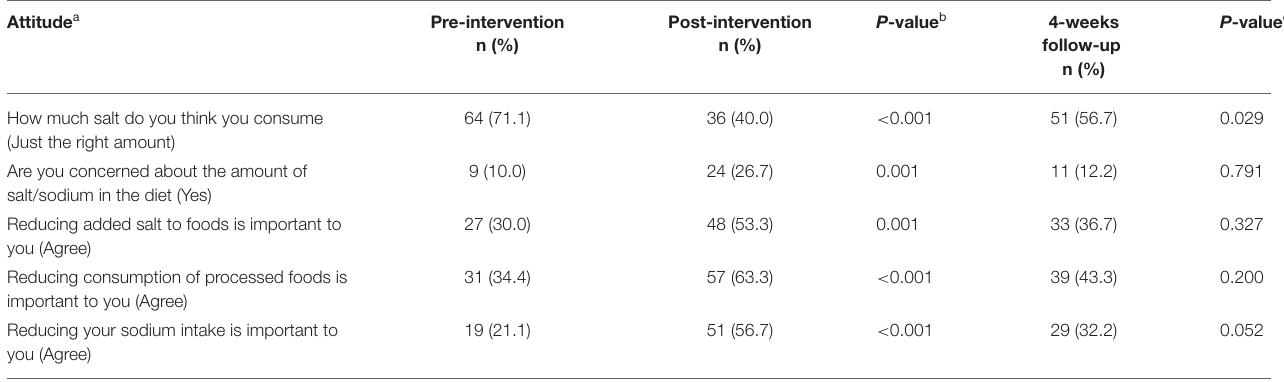
TABLE 3 | Pre-intervention, post-intervention and 4-week follow-up for attitude related responses of study participants ( n = 90). Attitude a Pre-intervention